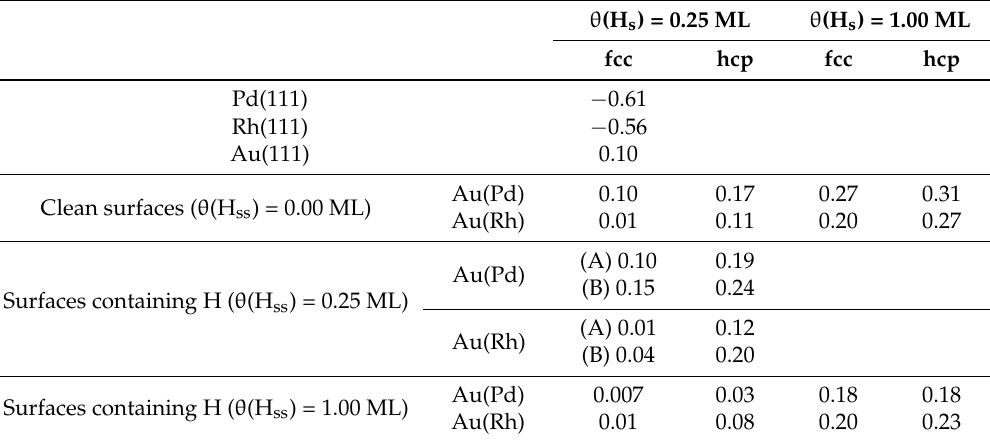
Table 3. Binding energy ∆ E bind of hydrogen adsorbed on mono- and bimetallic surfaces, calculated according to Equations (2) and (3). Hydrogen atoms ad- and absorbed on these surfaces are labeled H s and H ss , respectively. The binding energy was only calculated for the adsorbed H s atoms. The labels Au(Rh) and Au(Pd) correspond to a Rh or Pd complete monolayer (ML) in the Au(111) slab, respectively. The energies are in